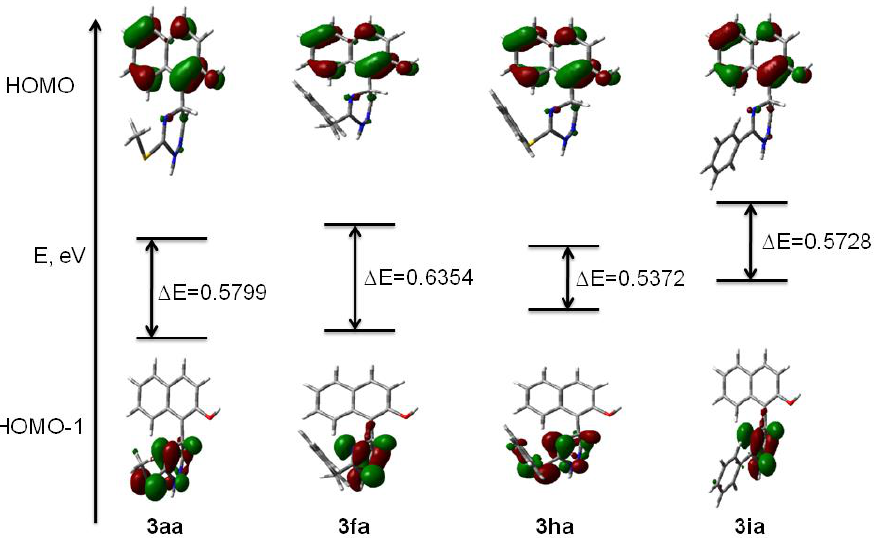
Figure 2. Localizations of electron density on nitrogen and oxygen atoms for compounds 3aa , 3fa , 3ha , and 3ia .